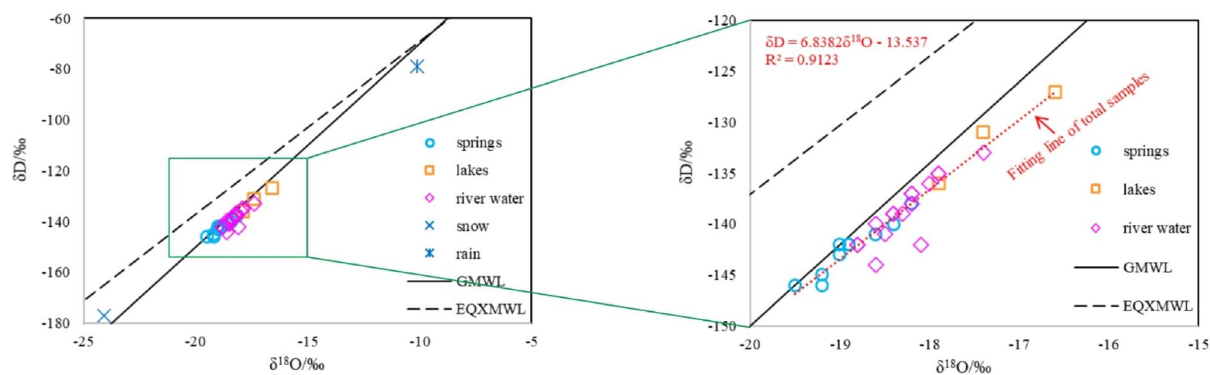
Figure 8. Plot of δ 18 O versus δD. The GMWL and EQXMWL are also shown.